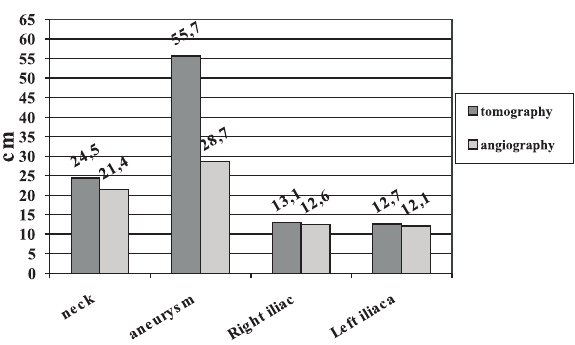
Fig. 2- Comparative graph of the mean diameters measured by spiral TC and by angiography (n=113).